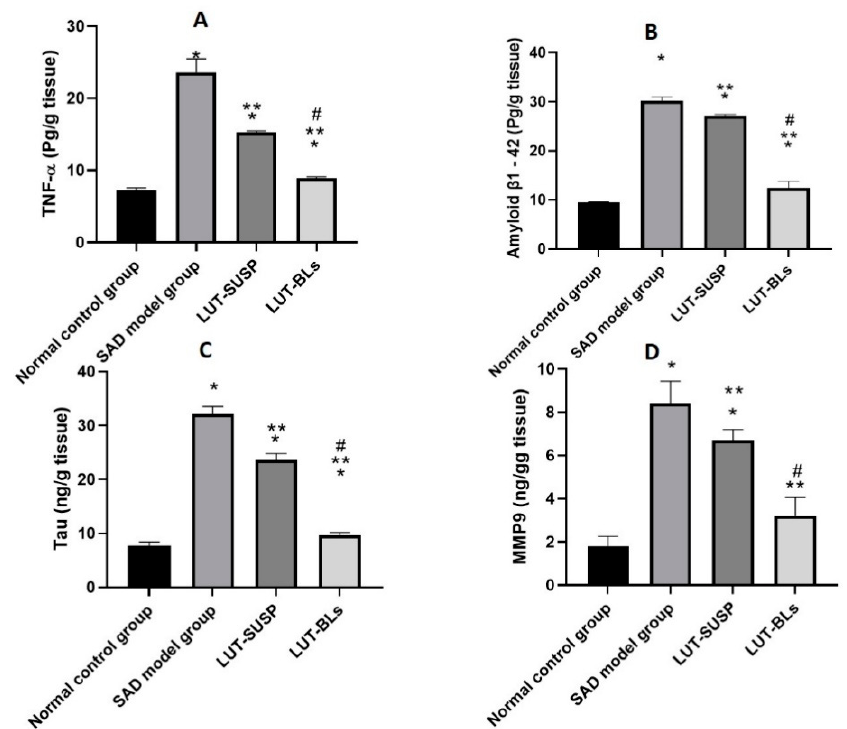
Figure 8. Biochemical analysis of ( A ) TNF- α level, ( B ) amyloid β 1-42 level, ( C ) tau level, and ( D ) MMP9 level. Animals were divided into four groups, one of which was designated as the normal control group. The second group received STZ (3 mg/kg, ICV). The remaining two groups were injected first with STZ (3 mg/kg, ICV), followed by injection with luteolin suspension (50 mg/kg, i.n. for 21 days) and luteolin-loaded bilosomes (50 mg/kg, i.n. for 21 days), respectively. The brain of the animals (n = 8) in each group was retrieved and homogenized as 10% homogenate in 0.1 M PBS before being centrifuged, and supernatants were used further analyses. Statistical analyses were performed using one-way analysis of variance (ANOVA) followed by the Tukey–Kramer post hoc test, whereby each value was presented as mean ± standard deviation (SD). * Statistically significantly different from the normal control group ( p < 0.05); ** statistically significantly different from the STZ group, 3 mg/kg ( p < 0.05); # statistically significantly different from the LUT suspension group, 50 mg/kg ( p < 0.05).